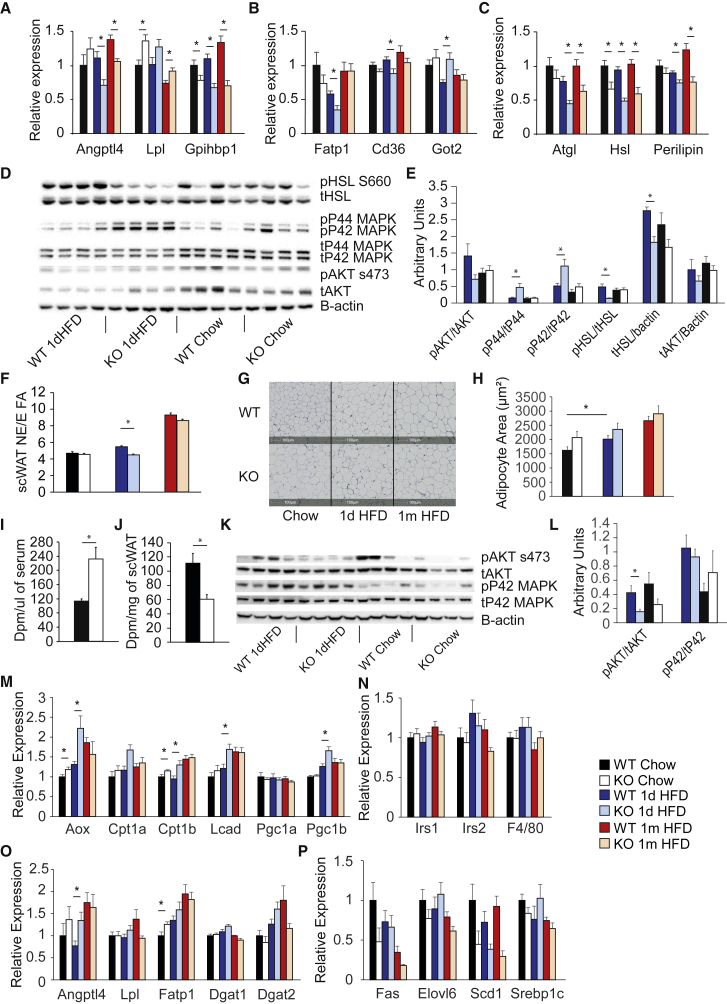
Mice Lacking PPARγ2 Cannot Appropriately Store Lipid in Adipose Tissue(A–C) Gene expression in WAT for (A) lipoprotein lipase and regulatory molecules and (B) FA uptake genes. (C) Markers of lipolysis (n = 8 mice per group except 1 month HFD KO [n = 7]).(D and E) Western blots of WAT: (D) representative western blots and (E) quantification (n = 8 mice per group).(F) The ratio of non-essential to essential FAs in adipose tissue from WT and PPARγ2-KO mice (n = 8 per group KO chow, 1 day HFD WT and KO, n = 7 per group, WT chow, 1 month HFD WT and KO).(G and H) Morphometric analysis of sections of WAT from WT and PPARγ2-KO mice: (G) representative images (scale bar shows 100 μM) and (H) quantification of adipocyte cross-sectional area (n = 8 per group KO chow, 1 day HFD KO and 1 month HFD WT, n = 7 per group, KO chow, 1dHFD WT 1 month HFD KO).(I and J) Radioactive palmitate levels in (I) blood and (J) scWAT from WT and PPARγ2-KO mice under hyperinsulinemic-euglycemic clamp conditions (n = 6 per group).(K and L) Western blots from muscle: (K) representative western blots and (L) quantification (n = 8 per group).(M–P) Gene expression in muscle for (M) FA oxidative markers, (N) insulin sensitivity markers, (O) lipid uptake and storage genes, and (P) lipid biosynthetic genes (n = 8 mice per group except 1 month HFD KO [n = 7]).For multiple time points, two-way ANOVA was performed, and if significant, pairwise comparisons were performed using two-tailed Student’s t test (∗p < 0.05). All mice were 4–5 months old. All data are represented as mean ± SEM. See also Figures S2 and S3.